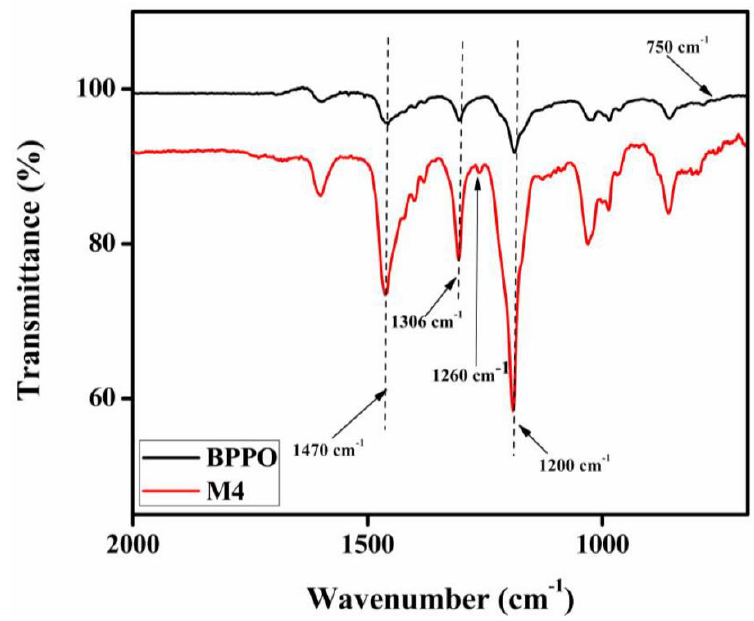
Figure 7. The infrared (IR) spectrum of pristine BPPO and M4 membranes.